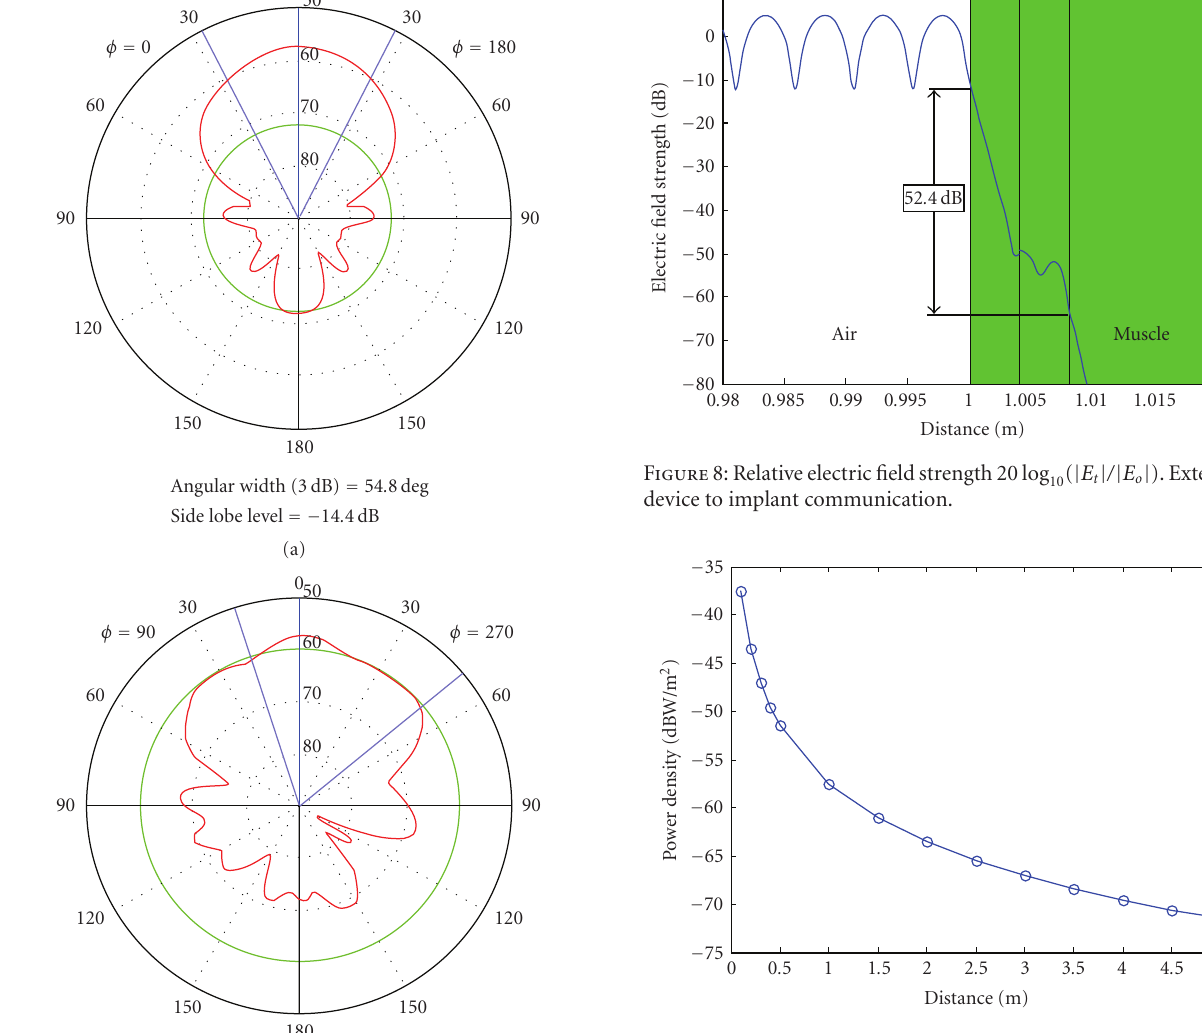
Figure 9: P-field from an implant as a function of